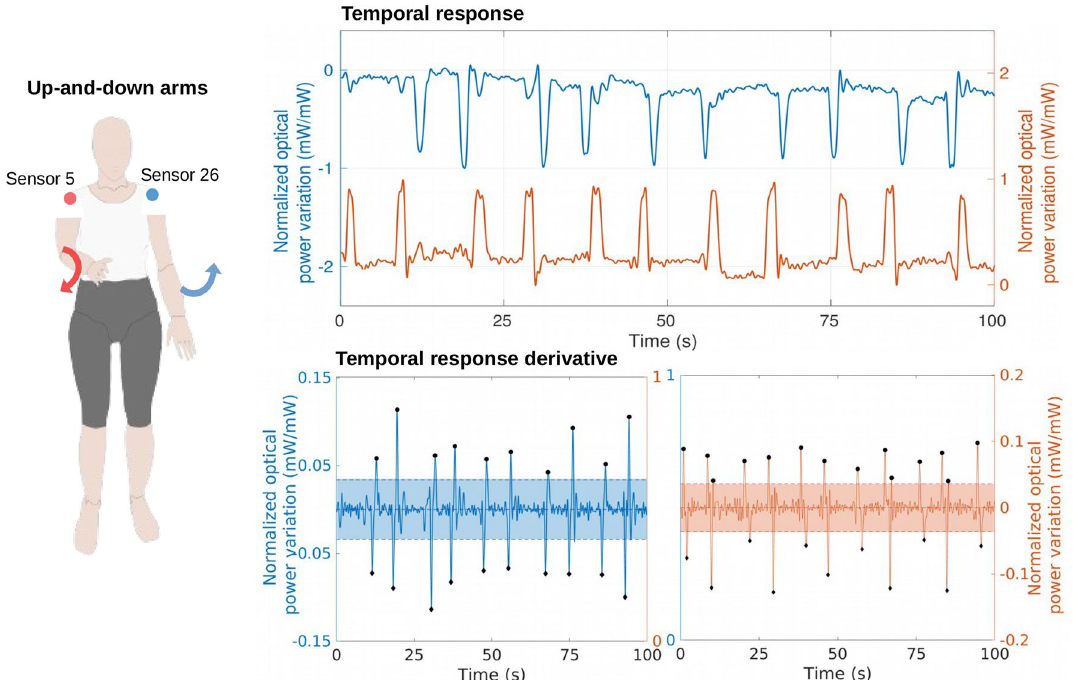
Figure 10. Results of the up-and-down arms test of the volunteer 1: temporal response of sensors 5 (right arm) and 26 (left arm) and identification of the shoulder flexion and extension by outliers detection using the temporal response